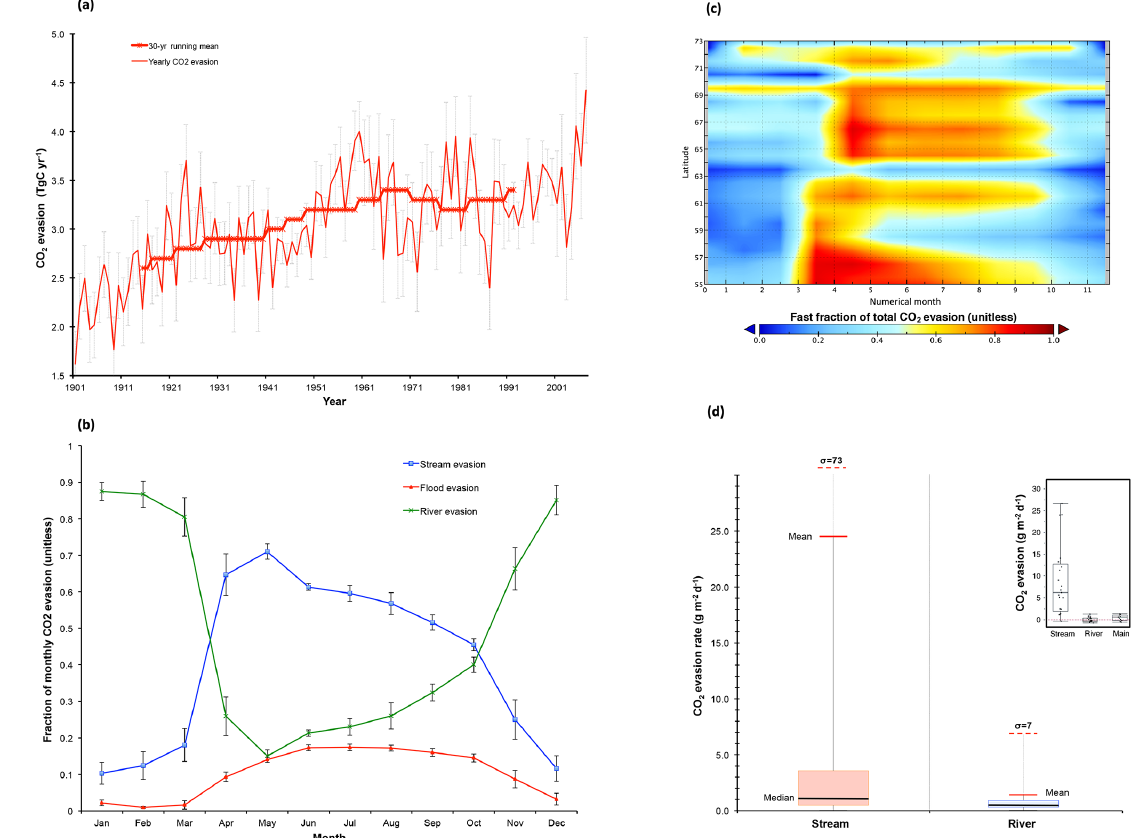
Figure 6. CO 2 evasion from stream, river, and flood reservoirs. (a) Time series of total yearly CO 2 evasion (tCyr − 1 ) summed over the three hydrological pools (red line) with the 30-year running mean of the same variable overlain in thick red (asterisk) symbols. Error bars give the standard deviation of each decade (e.g. 1901–1910) for each data point in that decade. (b) The fraction of total CO 2 evasion emitted from each of the hydrological pools for the average of each month over the period 1998–2007 is shown for river, flood, and stream pools (blue, green, and red lines, respectively), with error bars depicting the standard deviation of data values for each month displayed. (c) Hovmöller diagram showing the monthly evolution of the stream pool fraction (range 0–1) per month and per latitudinal band, averaged over the period 1998–2007. (d) Boxplot for approximate (see text) simulated CO 2 evasion (gCm − 2 d − 1 ) from the stream water reservoir and river water reservoir averaged over 1998–2007. Coloured boxes denote the first and third quartiles of the data range, and internal black bars are the median. Whiskers give the mean (solid red bar) and standard deviation (dashed red bar) of the respective data. Empirical data on these quantities using the same scale for rivers, streams, and main stem of the Kolyma river from Denfeld et al. (2013) are shown in the inset.